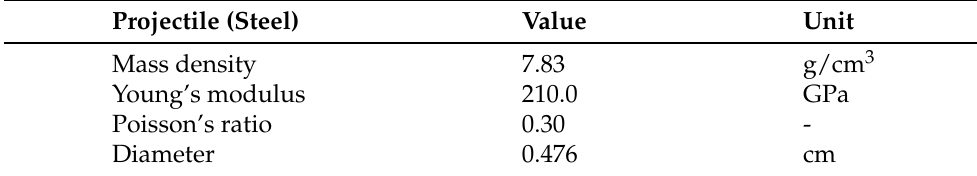
Table 3. Fixed system parameters of the projectile used in the ballistic